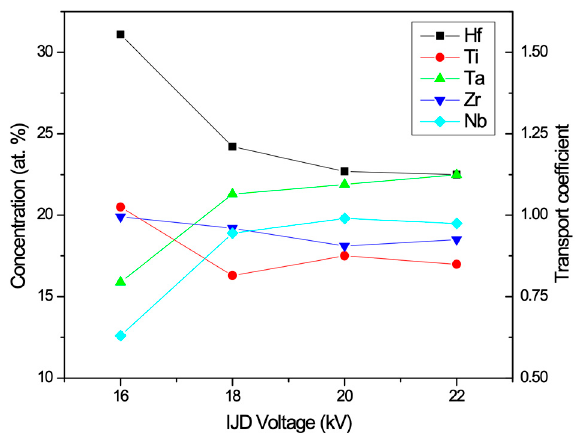
Figure 7. Influence of the applied IJD accelerating voltage on the resulting elemental composition of the grown film (vertical scale on the left side; only the elements listed in the legend are considered) and the corresponding calculated IJD transport coefficient (vertical scale on the right side).